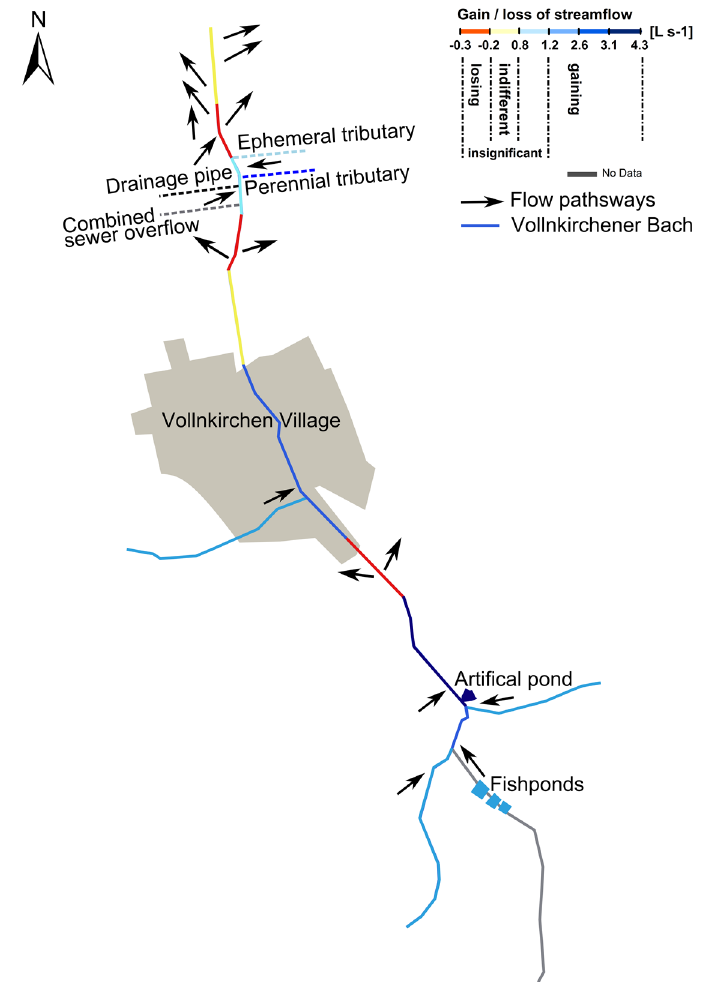
Figure 13. Schematic of flow pathways along the Vollnkirchener creek based on hydrodynamic results. Groundwater flow directions are symbolized by